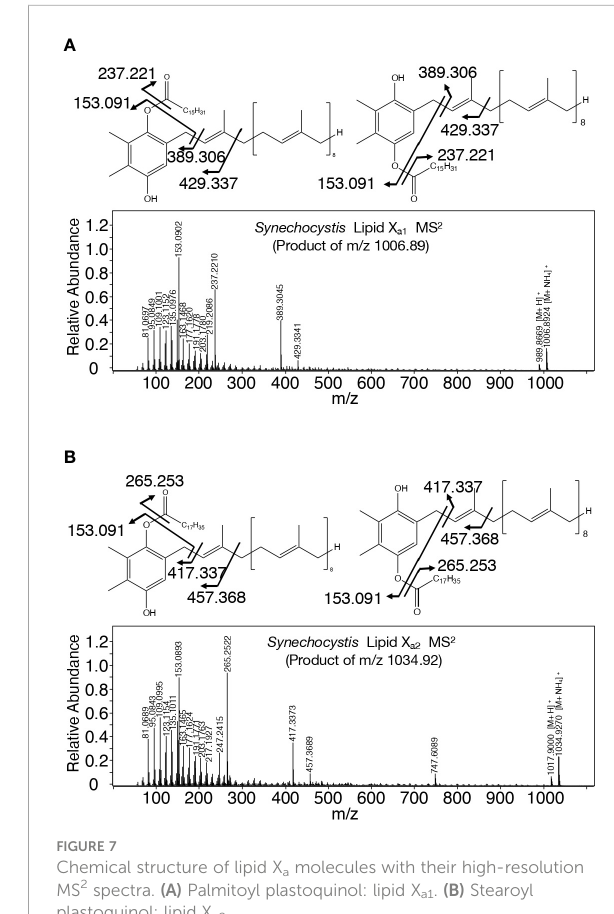
FIGURE 7 Chemical structure of lipid X a molecules with their high-resolution MS 2 spectra. (A) Palmitoyl plastoquinol: lipid X a1 . (B) Stearoyl plastoquinol: lipid X a2